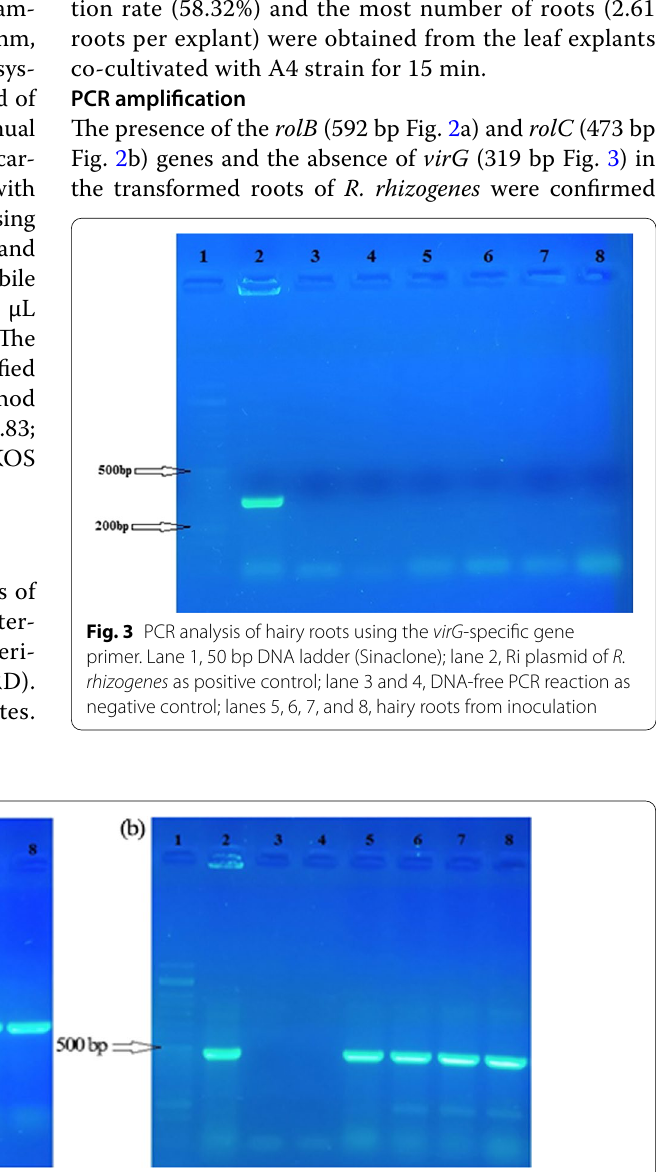
Fig. 2 PCR analysis of hairy roots obtained by inoculation with the A4 strain of R. rhizogenes using specific primers for the rolB gene ( a ) and the rolC gene ( b ). Lanes 1, 50 bp DNA ladder (Sinaclone); lane 2, Ri plasmid of R. rhizogenes as positive control; lane 3 and 4, DNA‑free PCR reaction as negative control; Lanes 5, 6, 7, and 8, Hairy roots from inoculation